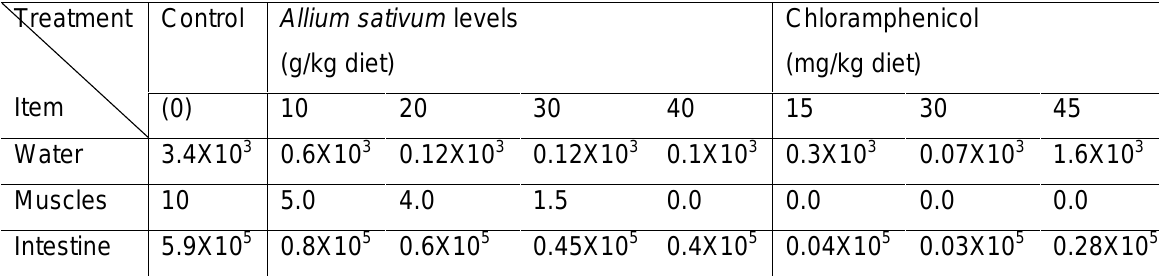
Table 10: Effects of Allium sativum and chloramphenicol on total coliforms count in muscles, intestine and water of treated O. niloticus